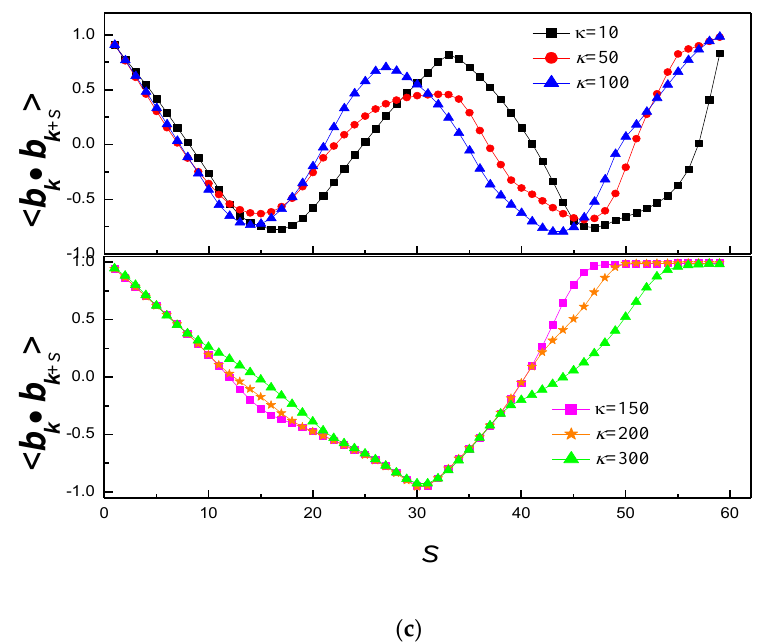
Figure 4. Tangent – tangent correlation of vesicle whose conformation is induced by linear polymer of different rigidities for ( a ) different rigidities for ( a ) ε VP = 2, ( b ) ε VP = 8, and ( c ) ε VP =